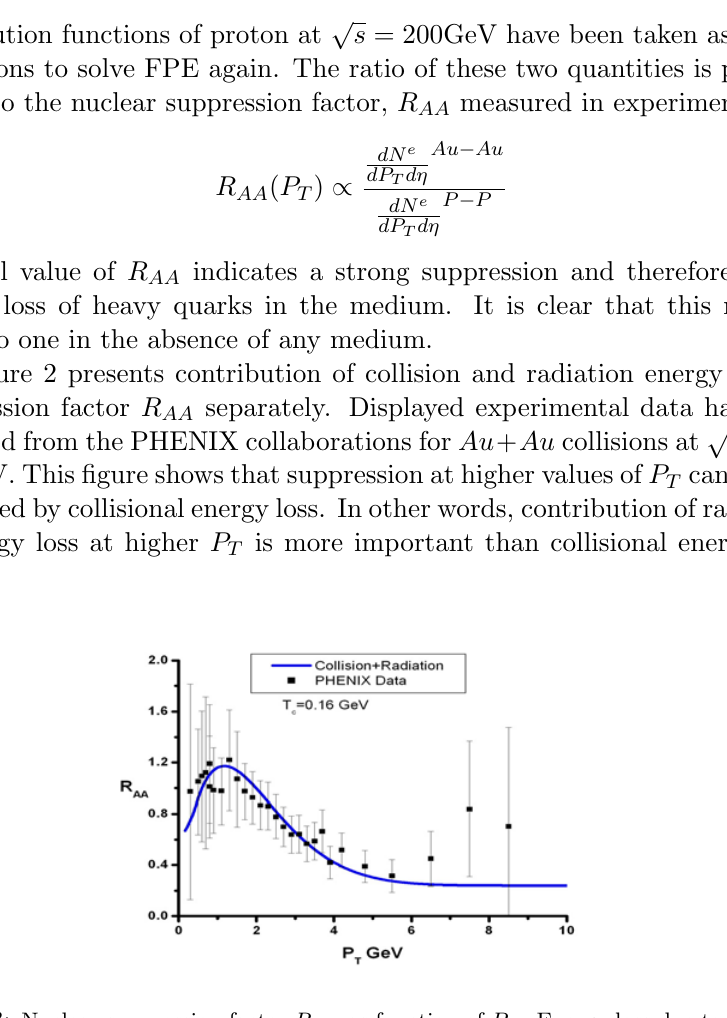
Figure 3: Nuclear suppression factor R AA as function of P T . Energy loss due to collision and radiation have been considered in calculating the drag